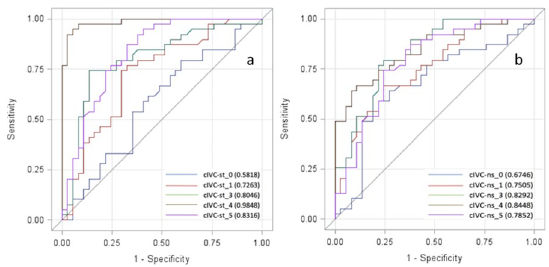
Fig. 1 Area under ROC curves of the collapsibility index of the inferior vena cava (cIVC) assessed during standardized (cIVC‑st, panel a) and unstandardized (cIVC‑ns, panel b) breathing conditions to predict fluid responsiveness. 0, 1, 3, 4, 5: measurement site of cIVC 0, 1, 3, 4 and 5 cm caudal to the right atrium F‑052 Search for trans‑thoracic echocardiography predictive